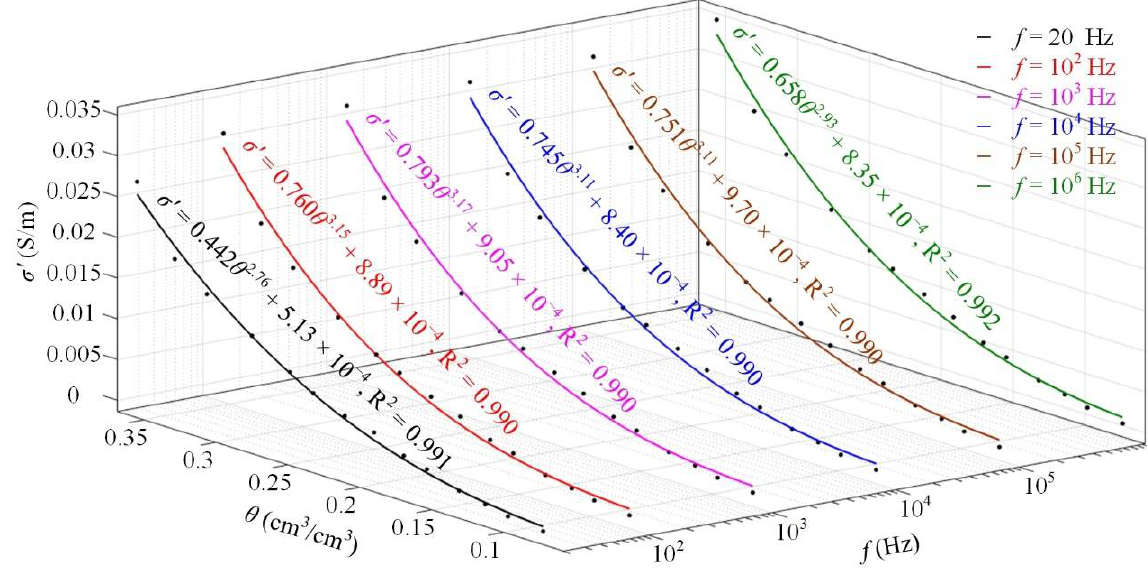
Figure 8. Fitted relations between in-phase substrate conductivity and volumetric water content at different frequencies for a typical set of substrates at nearly equal dry densities. The mean and standard deviation of the related dry densities (Table 1) are 0.398 g/cm 3 and 4.97 × 10 −3 , respectively.